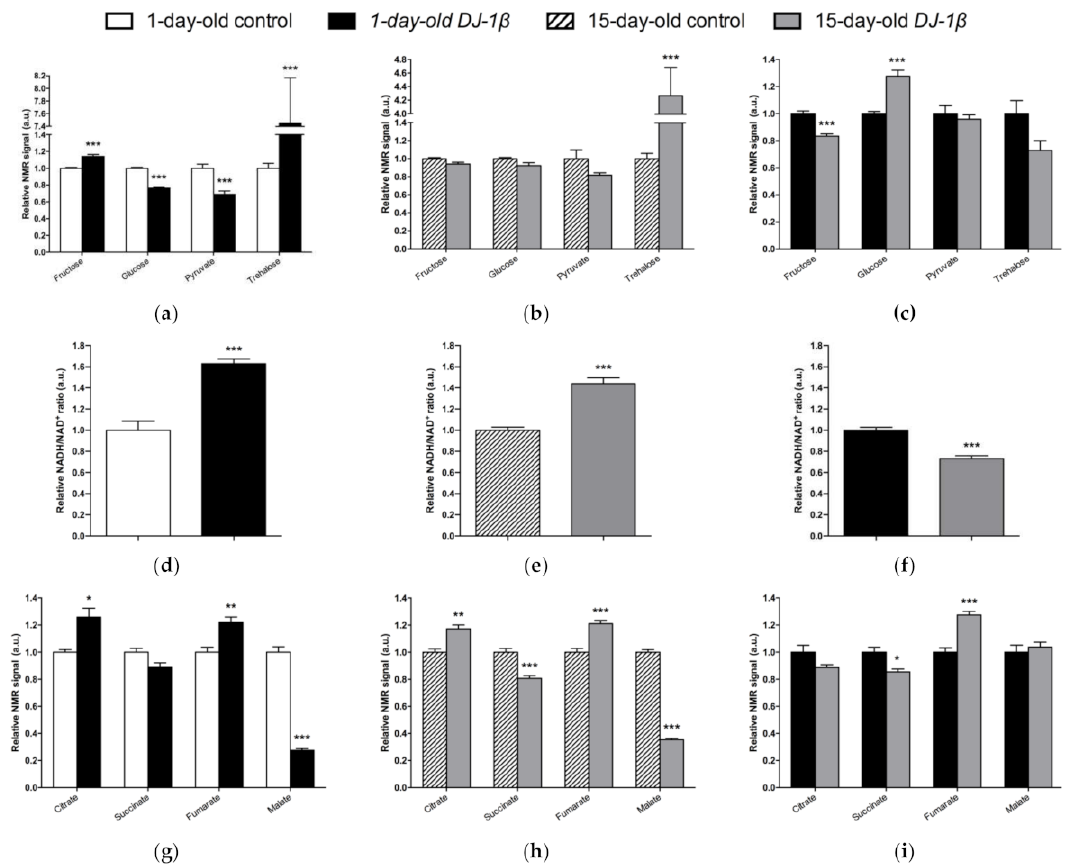
Figure 4. Alterations in carbohydrate content in DJ-1 β mutant flies. Relative NMR signals of selected carbohydrates in between ( a ) 1-day-old DJ-1 β mutant and control flies, ( b ) 15-day-old DJ-1 β mutant and control flies, and ( c ) 1-day-old and 15-day-old DJ-1 β mutant flies. Relative NADH/NAD + ratio in ( d ) 1-day-old DJ-1 β mutant and control flies, ( e ) 15-day-old DJ-1 β mutant and control flies, and ( f ) 1-day-old and 15-day-old DJ-1 β mutant flies. Relative NMR signals of TCA cycle intermediates comparing ( g ) 1-day-old DJ-1 β mutant and control flies, ( h ) 15-day-old DJ-1 β mutant and control flies, and ( i ) 1-day-old and 15-day-old DJ-1 β mutant flies. In all cases, error bars show s.d. from twelve independent samples (*, p < 0.05; **, p < 0.01; ***, p <